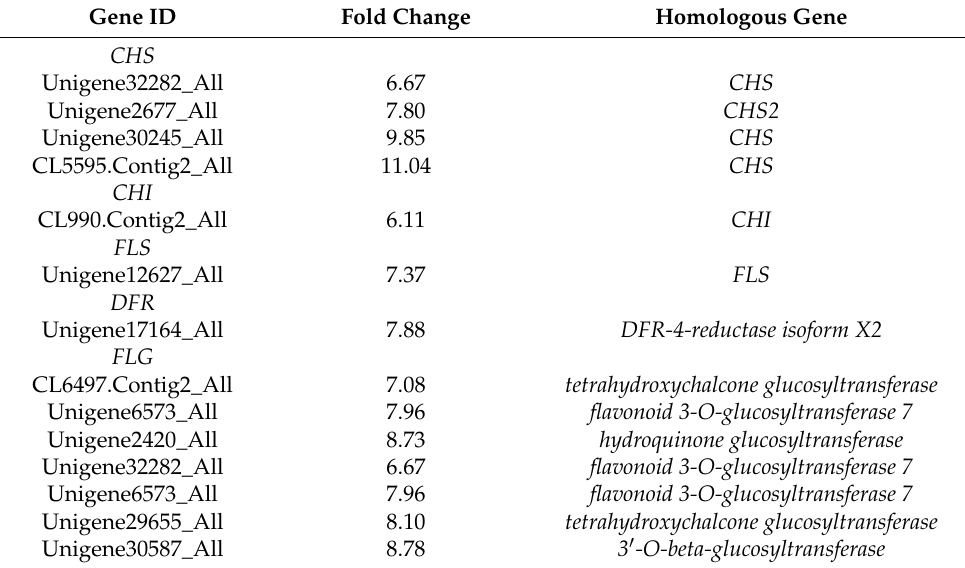
Table 7. The upregulated DEGs related to flavonoids in the leaves of A. canescens under 100 mM NaCl, but not under control conditions, for 6